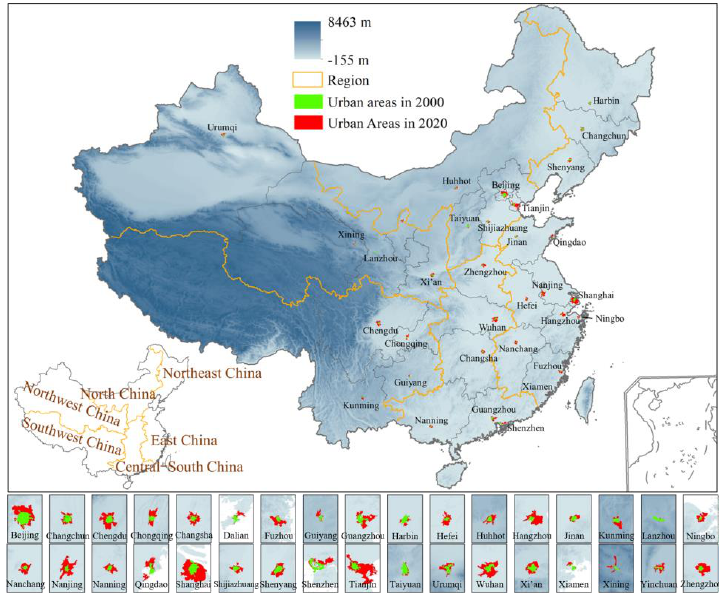
Figure 1. The spatial distribution of 34 municipal cities and 6 regions in China. Panels at the bottom show the urban areas of each city in 2000 (green) and 2020 (red), all at the same scale.